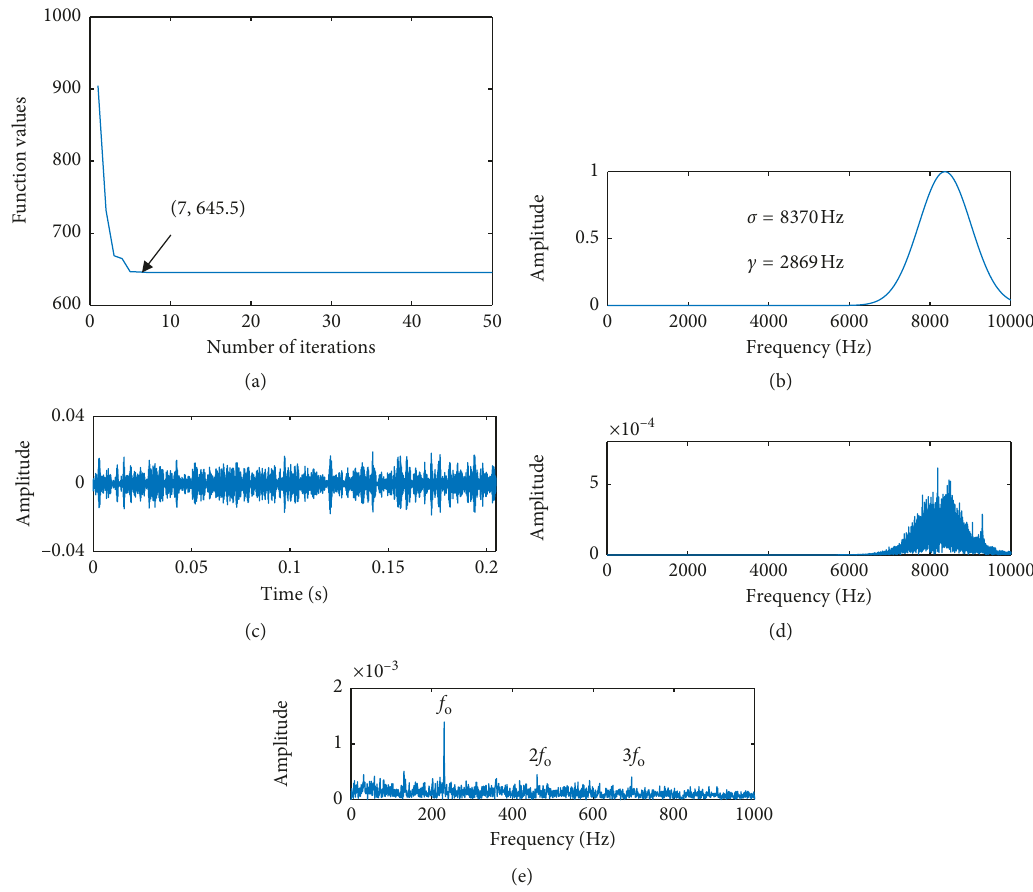
Figure 22: Diagnosis results of the life cycle fault using the approach proposed in the paper: (a) iteration curves for determining the optimal ARLW parameters; (b) FS of the optimal ARLW for detecting the outer ring defect information; (c) TW of the filtered signal obtained by (b); (d) FS of (c); (e) ES of